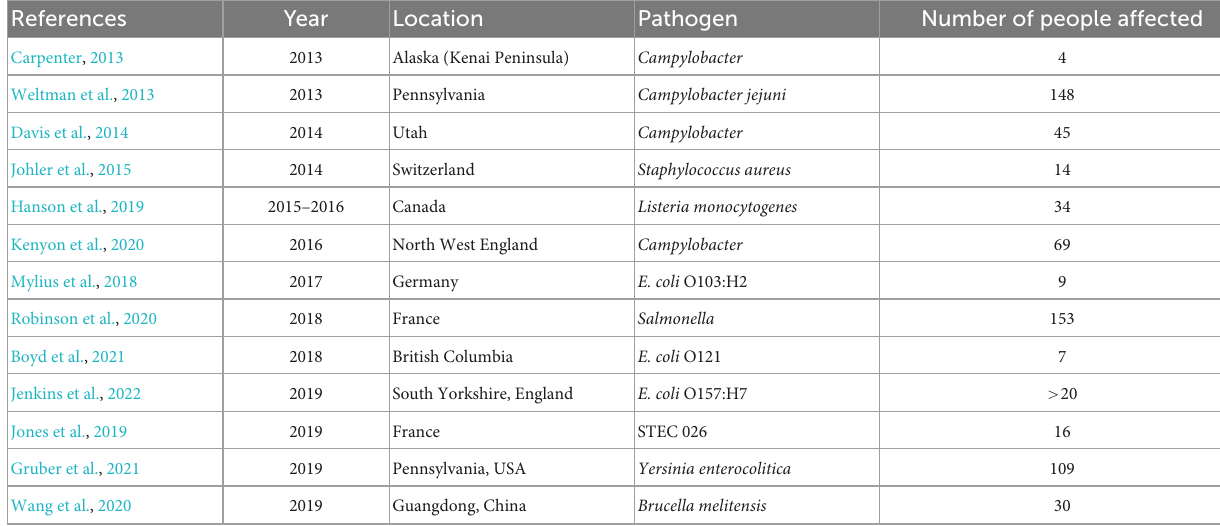
TABLE 2 Outbreaks of milk borne zoonotic diseases from 2013 to